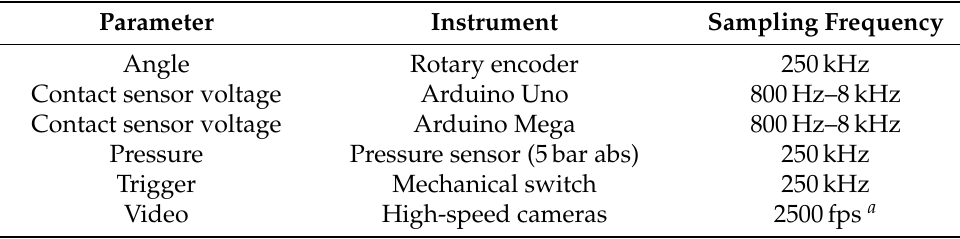
Table 1. Instrumentation.